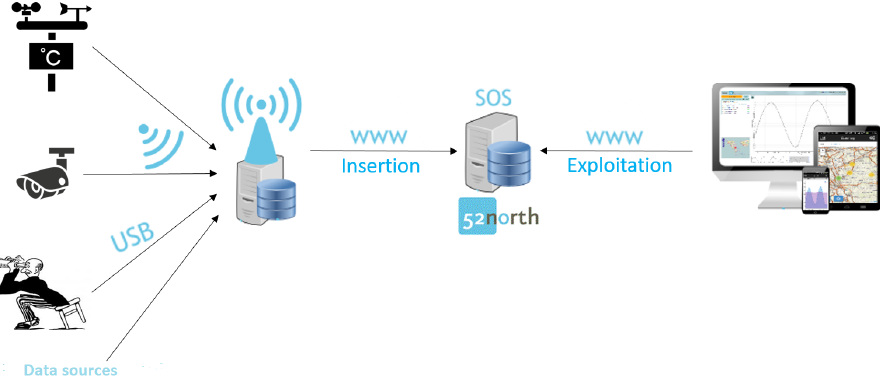
Figure 16. General architecture of the Information System